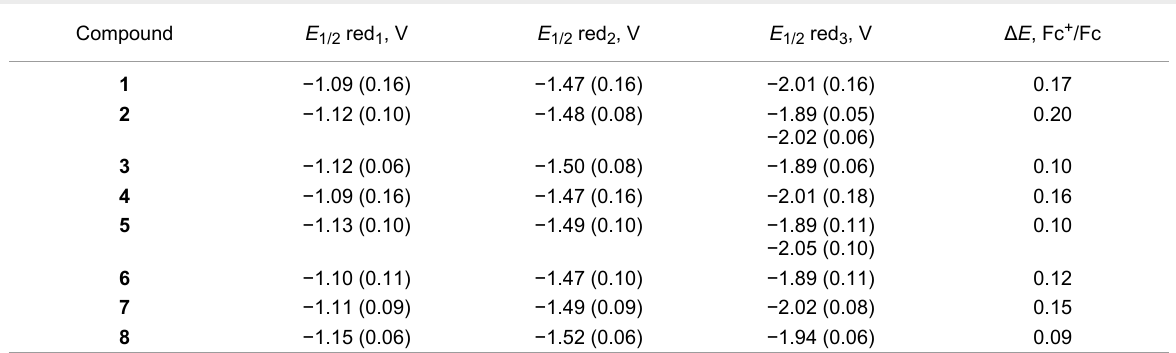
Table 1: Electrochemical data a for fullerene based compounds 1 – 8